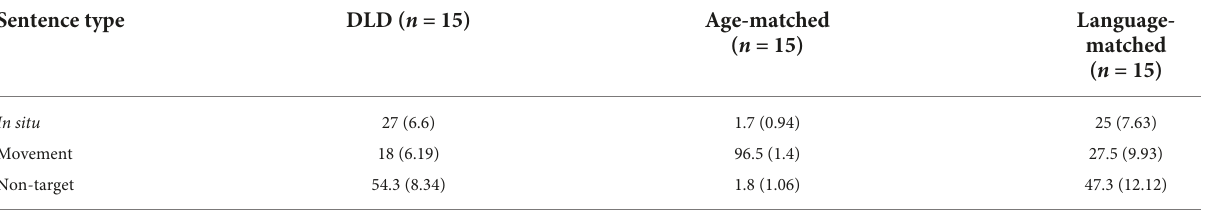
TABLE 6 Answer types provided across all conditions in Wh- question elicitation for the three groups.